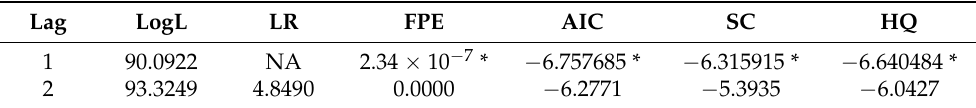
Table 7. Optimal lag order of the VAR model.